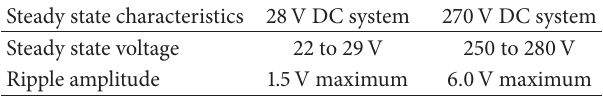
Table 1: DC normal operation